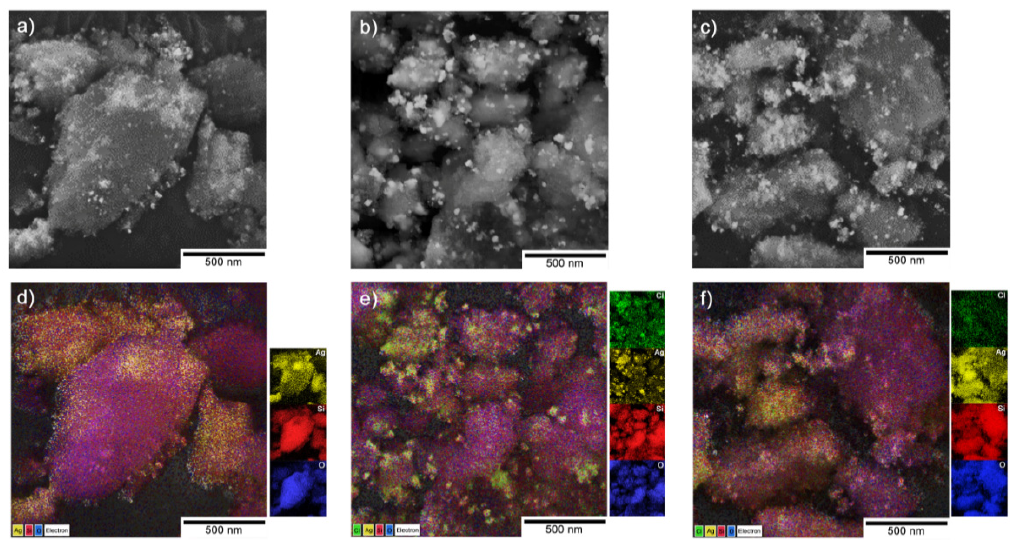
Figure 4. Backscattered electron (BSE)-SEM ( a – c ) images present the morphology of ( a ) Ag / SiO 2 , ( b ) Ag / SiO 2 @CMC, ( c ) Ag / SiO 2 @AS and the SEM-energy dispersive spectrometer (EDS) chemical composition maps of the ( d ) Ag / SiO 2 , ( e ) Ag / SiO 2 @CMC, and ( f ) Ag / SiO 2 @AS nanocomposites and their derivatives. The small insets highlight the individual elemental distribution maps of Ag (yellow), Si (red), O (blue), and Cl (green) from the EDS. CMC means carboxymethylcellulose, while AS refers to sodium alginate.